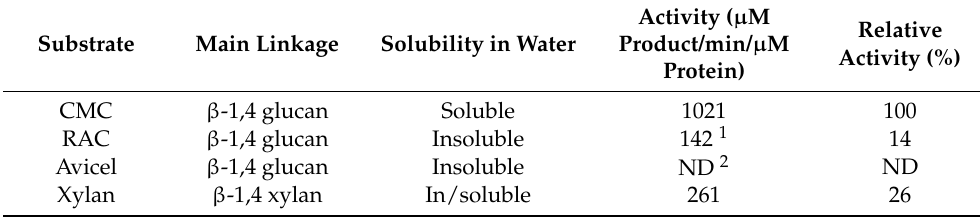
Table 1. Substrate preference of Calk